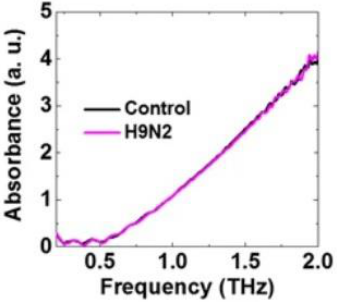
Figure 3. A comparison of the absorption spectra of a pellet of H9N2 virus (violet line) and a control sample (black) without the virus [83]. Reprinted from [83].